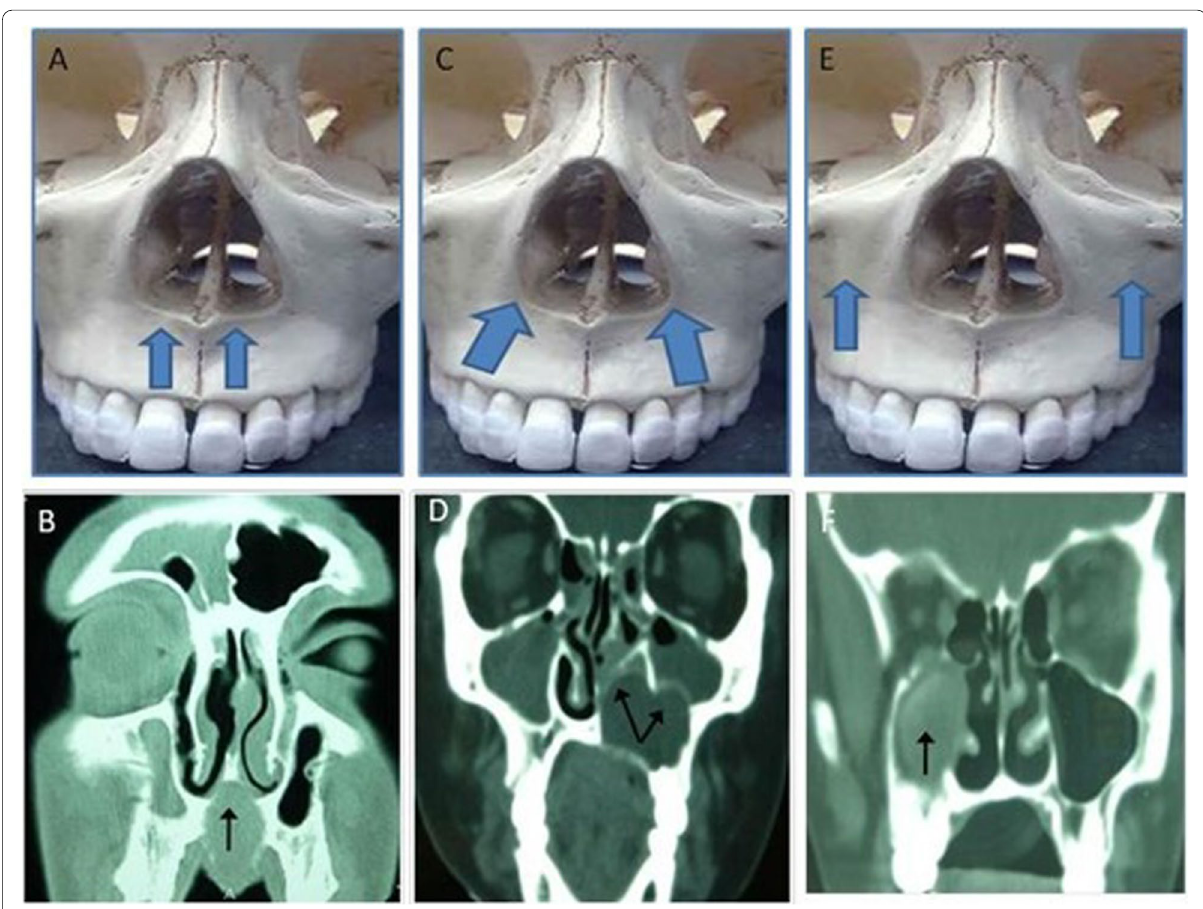
Fig. 1 Relationship between the origin of odontogenic cysts and direction of expansion of the maxillary walls. A Cysts originating from the central incisors with the direction of expansions (arrow). B Coronal CT image of a periapical cyst, showing an expansive process displacing the nasal cavity floor (black arrow) with intact and sclerotic borders. C Cysts originating from the lateral incisors and canines with directions of expansion (arrows). D Coronal CT image of a periapical cyst of the maxilla originating from non-vital left canine, showing an expansive process displacing part of the nasal cavity floor, inferior turbinate, and maxillary sinuses, with intact and sclerotic borders and occupying the majority of the left maxillary sinus (arrows). Associated pan rhinosinusitis was also observed. E Cysts originating from premolars and molars with the direction of displacements of the maxillary sinus floor (arrow). F Coronal CT image of a radicular cyst originating from the right second molar, expanding, and occupying the majority of the left maxillary sinus (arrow) with a very thin sclerotic border